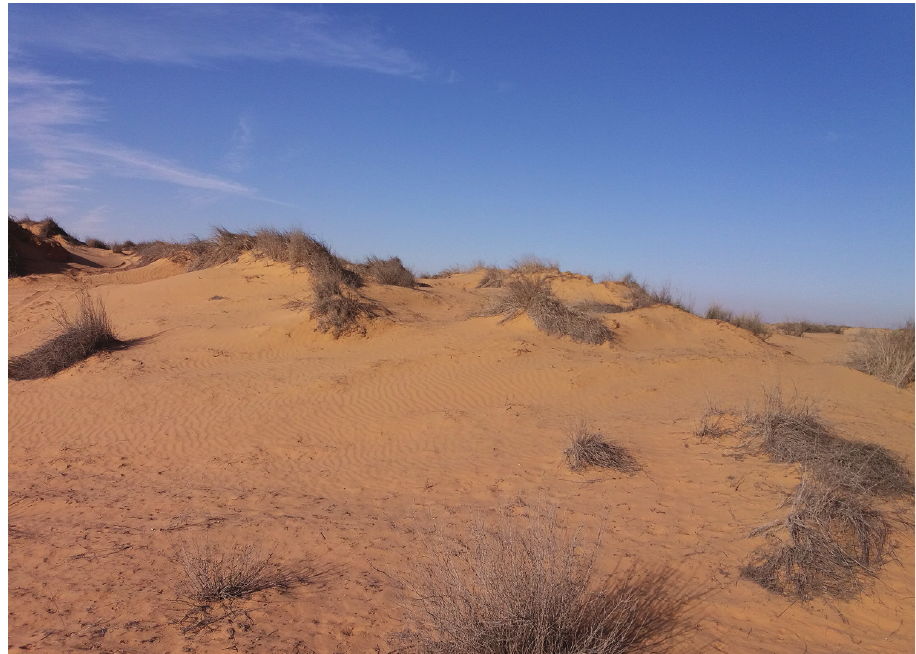
Figure 14. Habitat of Graphipterus serrator : Shifting sand dunes in the Western Negev Sands,